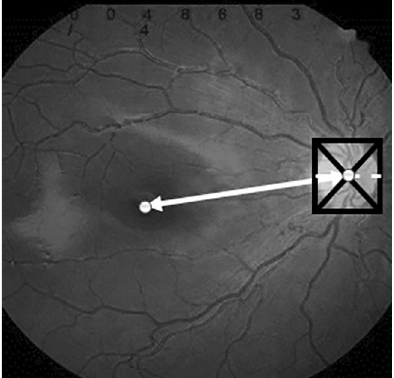
Figure 1. Macula-to-disc distance. A rectangle is positioned around the border of the optic disc. The center of the rectangle is determined by drawing lines from the corners of the rectangle. The short diameter of the neural tissue of the optic disk (DD, white dotted line) and the distance between the center of the disc and the center of the macula (DM, white arrow) are measured.